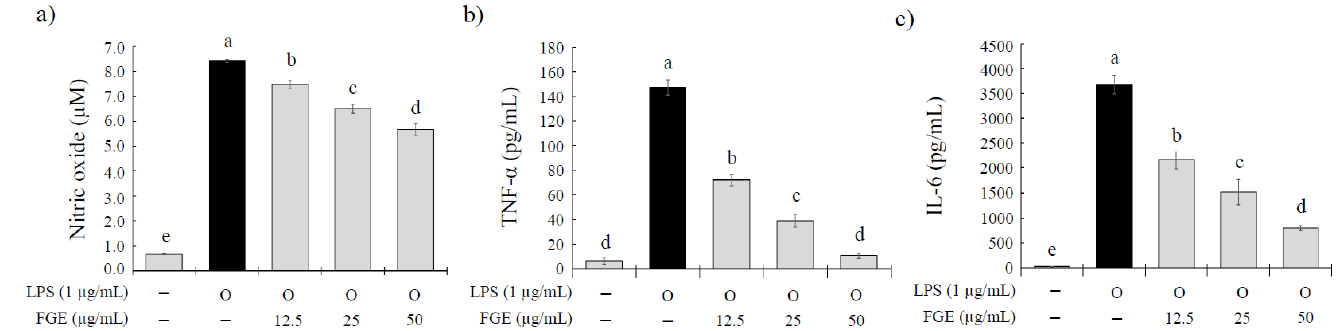
Figure 3. Effect of Filipendula glaberrima Nakai extract on the production of NO, TNF- α , and IL-6 protein expression in LPS-treated RAW 264.7 cells. RAW 264.7 cells were treated with each sample for 30 min, and then stimulated with LPS (1 µg/mL) for a further 24 h. The production of ( a ) NO, ( b ) TNF- α, and ( c ) IL-6 were analyzed using a Griess assay and ELISA method, respectively. The results are expressed as mean ± S.D. of three independent tests in triplicate. Different superscripts mean a significant difference among groups ( p < 0.05) based on a one- way ANOVA and Duncan’s multiple range test. FGE, ethanol extract of Filipendula glaberrima Nakai; NO, nitric oxide; TNF- α, tumor ne- crosis factor-alpha; IL-6, interleukin-6.